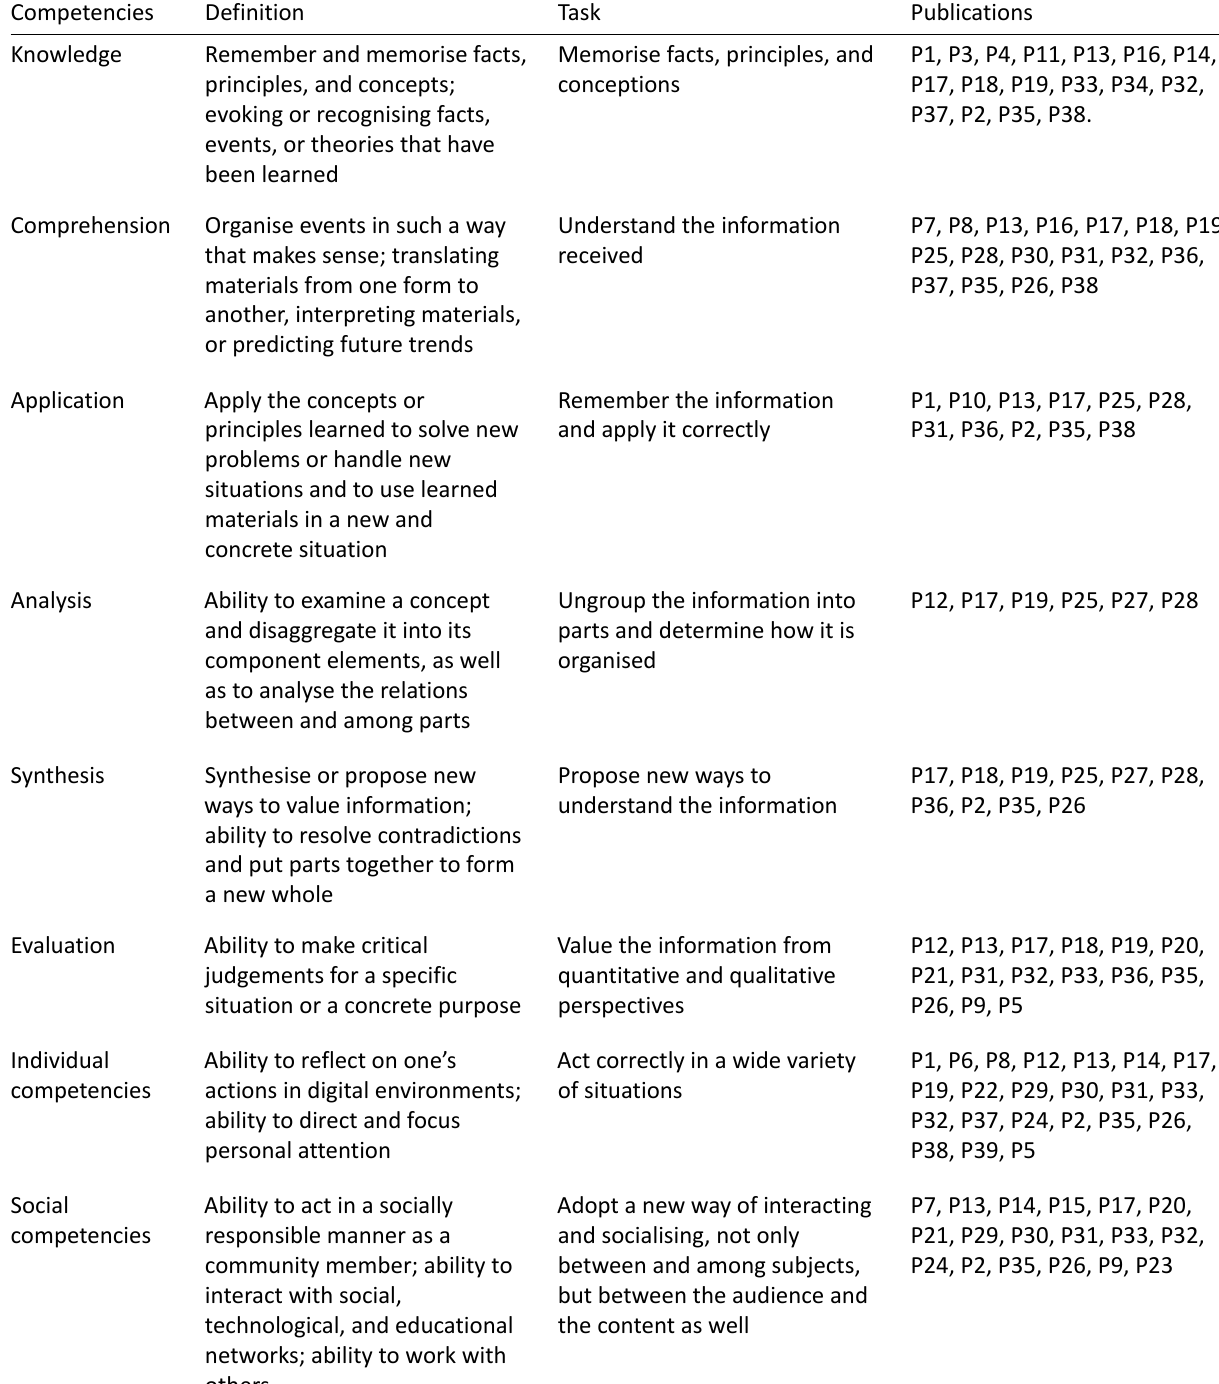
Table 3. Digital competencies for new journalistic work in media organisations.